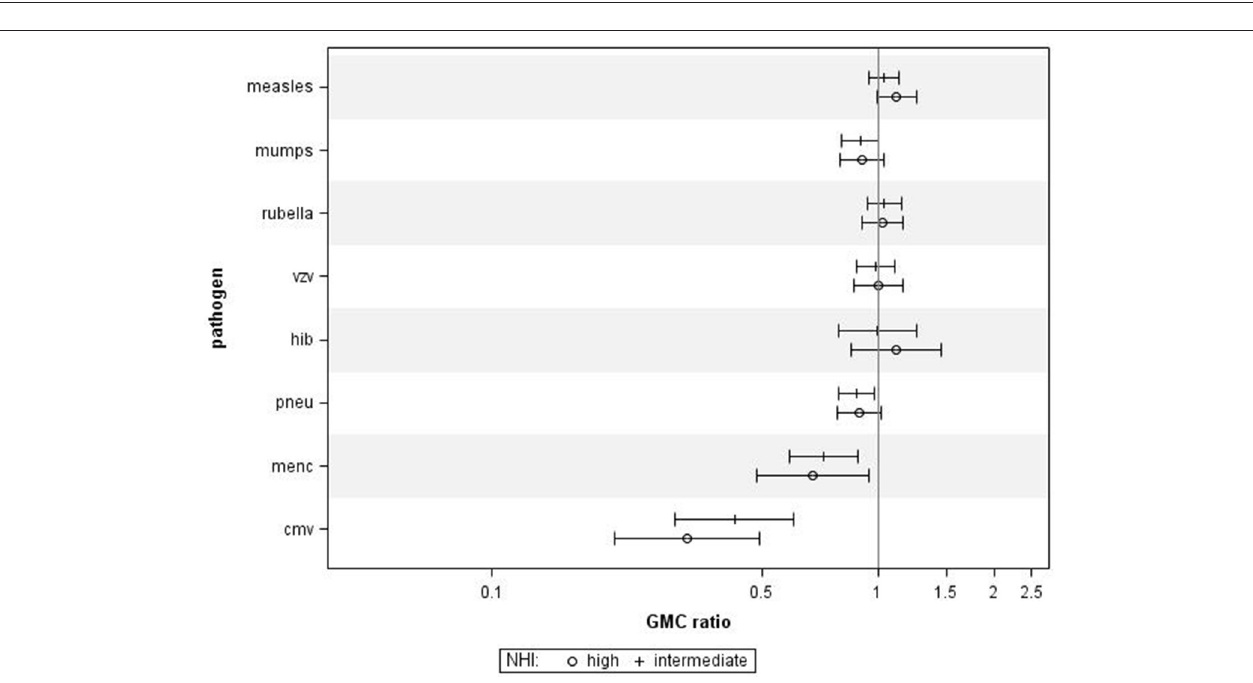
FIGURE 2 | Crude geometric mean concentration ratios per pathogen of high and intermediate net household income (NHI) level vs. low NHI with corresponding 95% C.I. N = 2,172.